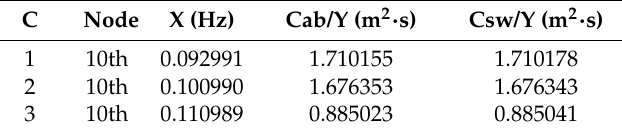
Figure 15. 10th spectrum of condition 1. Table 11. Spectrum analysis of node 10.